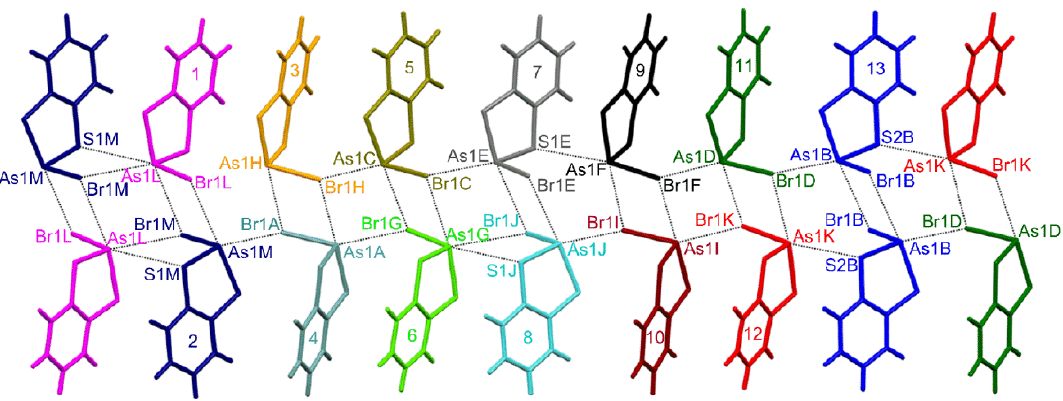
Figure 4. Fragment of a chain in compound 2 showing As ··· Br and As ··· S close contacts. Molecules are presented in di ff erent colors to highlight the 13 crystalographically independent molecules in the asymmetric unit.